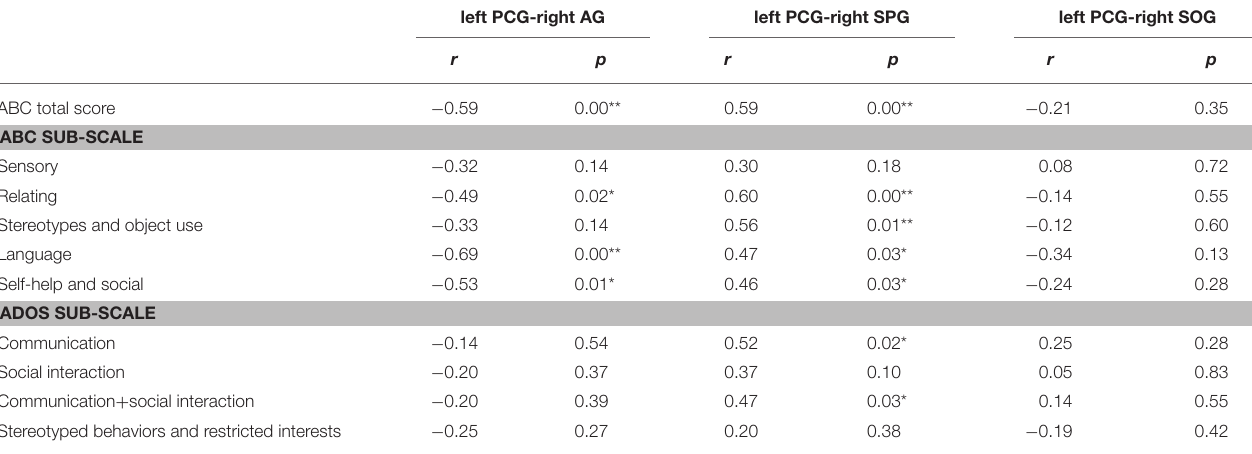
TABLE 3 | Behavioral correlations with abnormal functional connectivity in ASD group ( n = 24). left PCG-right AG left PCG-right